Question: How would you classify this visualization?
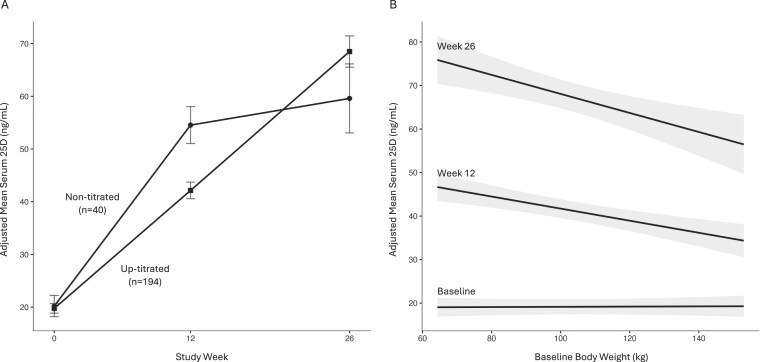
Answer: bar